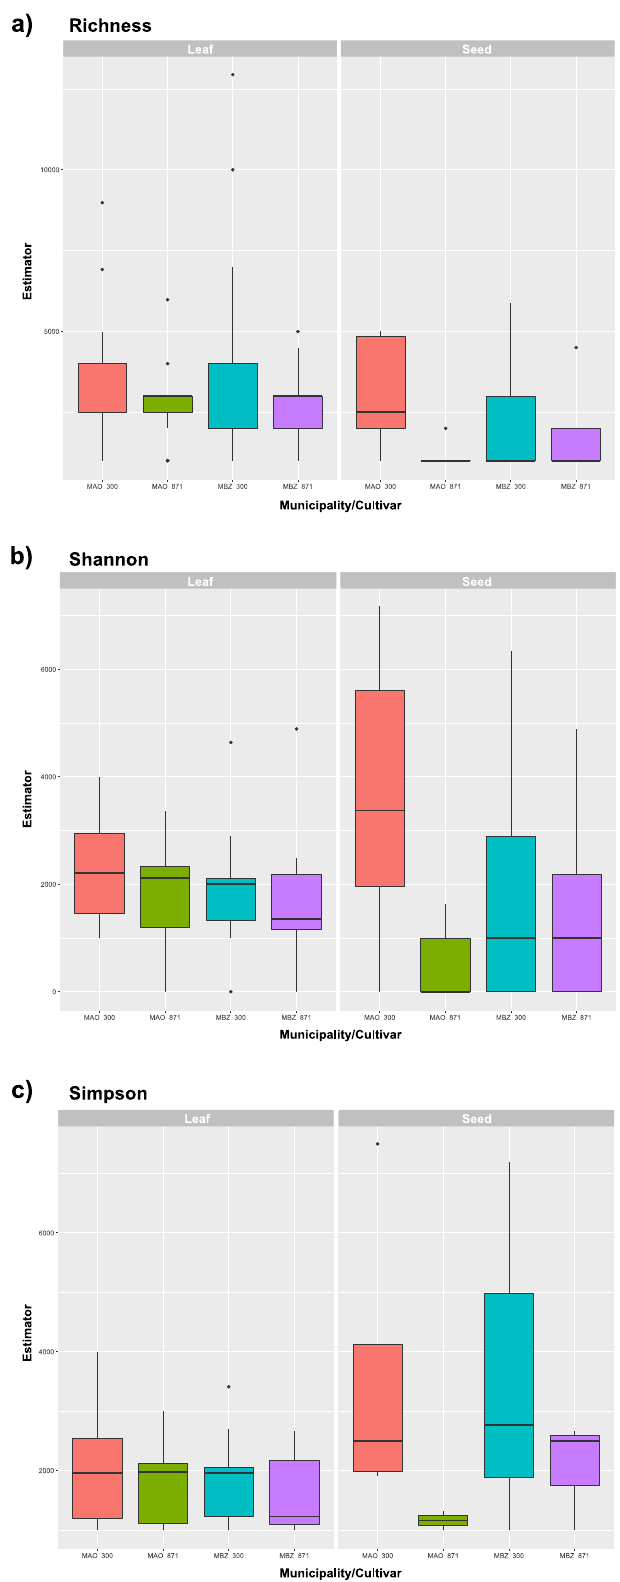
Figure 4. Diversity indexes estimates based on fungal populations obtained from guarana leaves and seeds of susceptible (BRS300) and resistant (BRS871) plant genotypes from Manaus (MAO) and Mau é s (MBZ), Amazonas, Brazil. ( a ) species richness; ( b ) Shannon diversity; and ( c ) Simpson